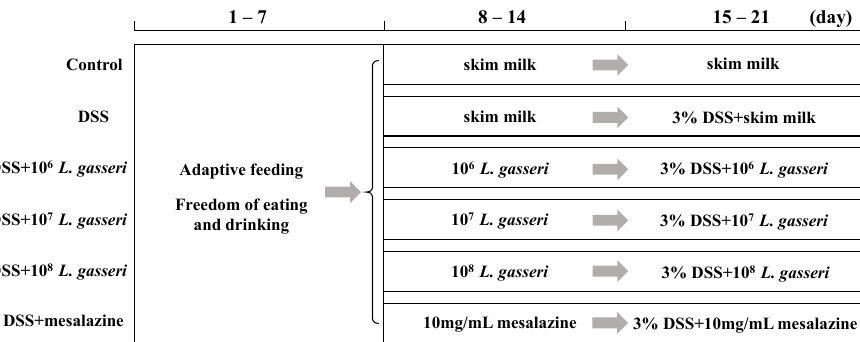
Figure 1. Grouping and intragastric administration in animal experiments.